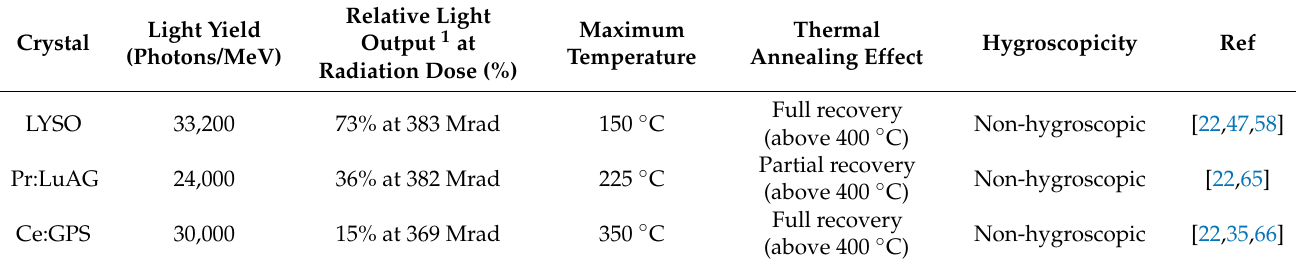
Table 4. Performances of selected scintillators and critical parameters for a nuclear reactor monitoring system.